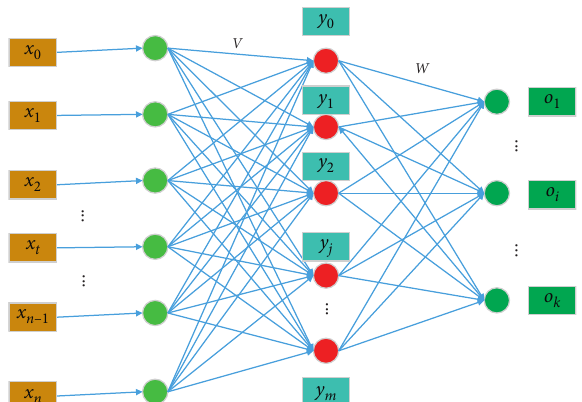
Figure 3: Structure diagram of RBF neural